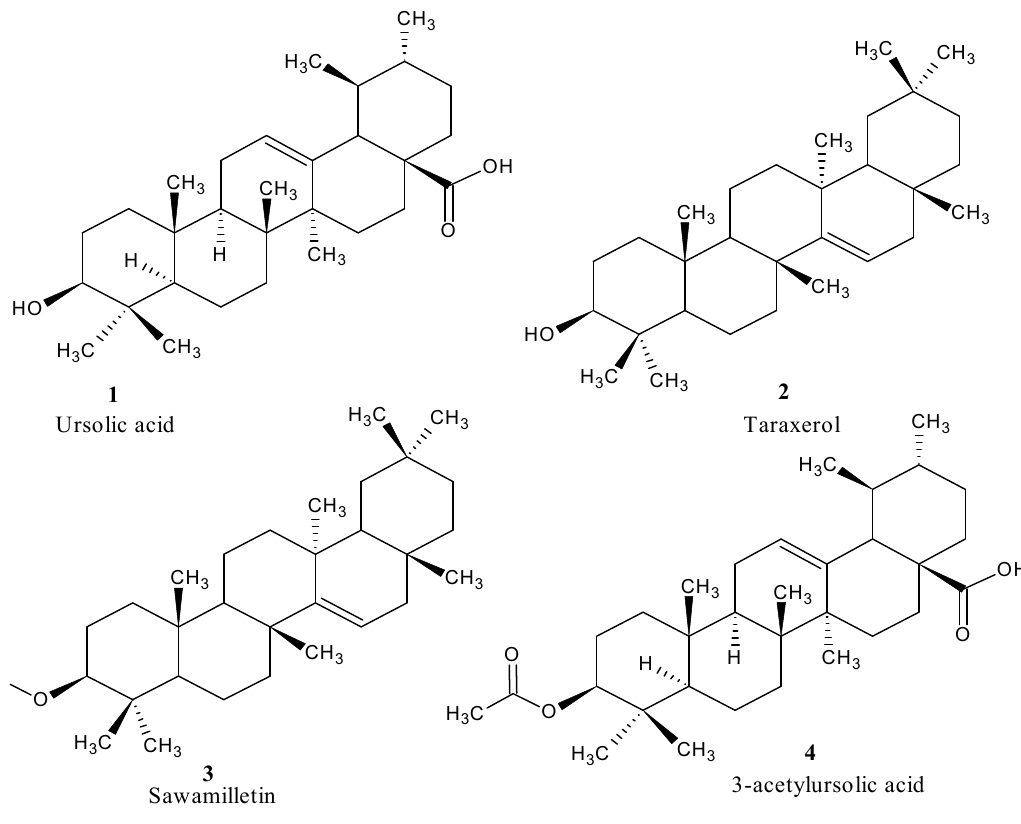
Figure 1. Chemical structures of the isolated triterpenes.